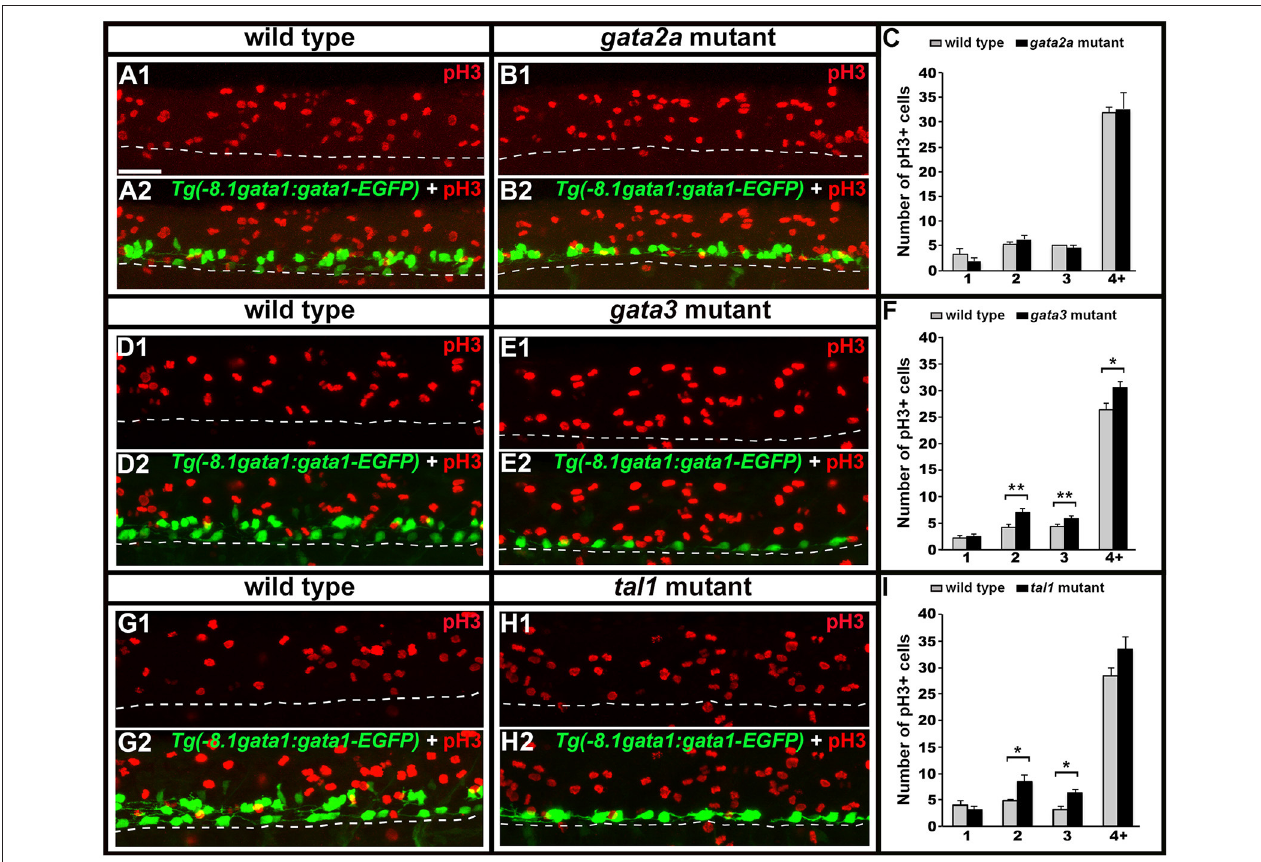
FIGURE 12 | Phospho-histone H3 (pH3) immunohistochemistry in tal1 , gata3, and gata2a mutants. Lateral views of pH3 (red) and GFP (green) immunohistochemistry in 24h Tg(-8.1gata1:gata1-EGFP) WT sibling and mutant embryos as indicated (A,B,D,E,G,H) . Top panel (1) in each case shows just the red channel and bottom panel (2) shows the merged image of both green and red channels. Tg(-8.1gata1:gata1-EGFP) embryos were used to help orientate to particular rows/cell type regions in the ventral spinal cord. Dorsal, top; anterior, left. Scale bar = 50 microns. Dashed lines indicate ventral limit of spinal cord. Mean number of pH3-positive cells in each D/V row of spinal cord region adjacent to somites 6–10 in WT and mutant embryos (C,F,I) . All counts are an average of at least 3 embryos. Cell rows were assigned based on average cell diameters. Error bars indicate SEM. Statistically significant comparisons are indicated with brackets and stars. * P < 0.05, ** P < 0.01. For P- values see Supplementary Table